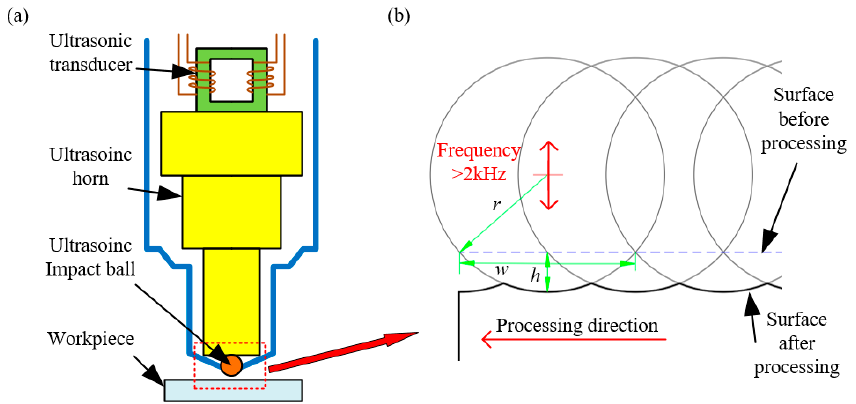
Figure 1. Principle of surface texture fabrication based on UIP. ( a ) Global view; ( b ) Enlarged view.